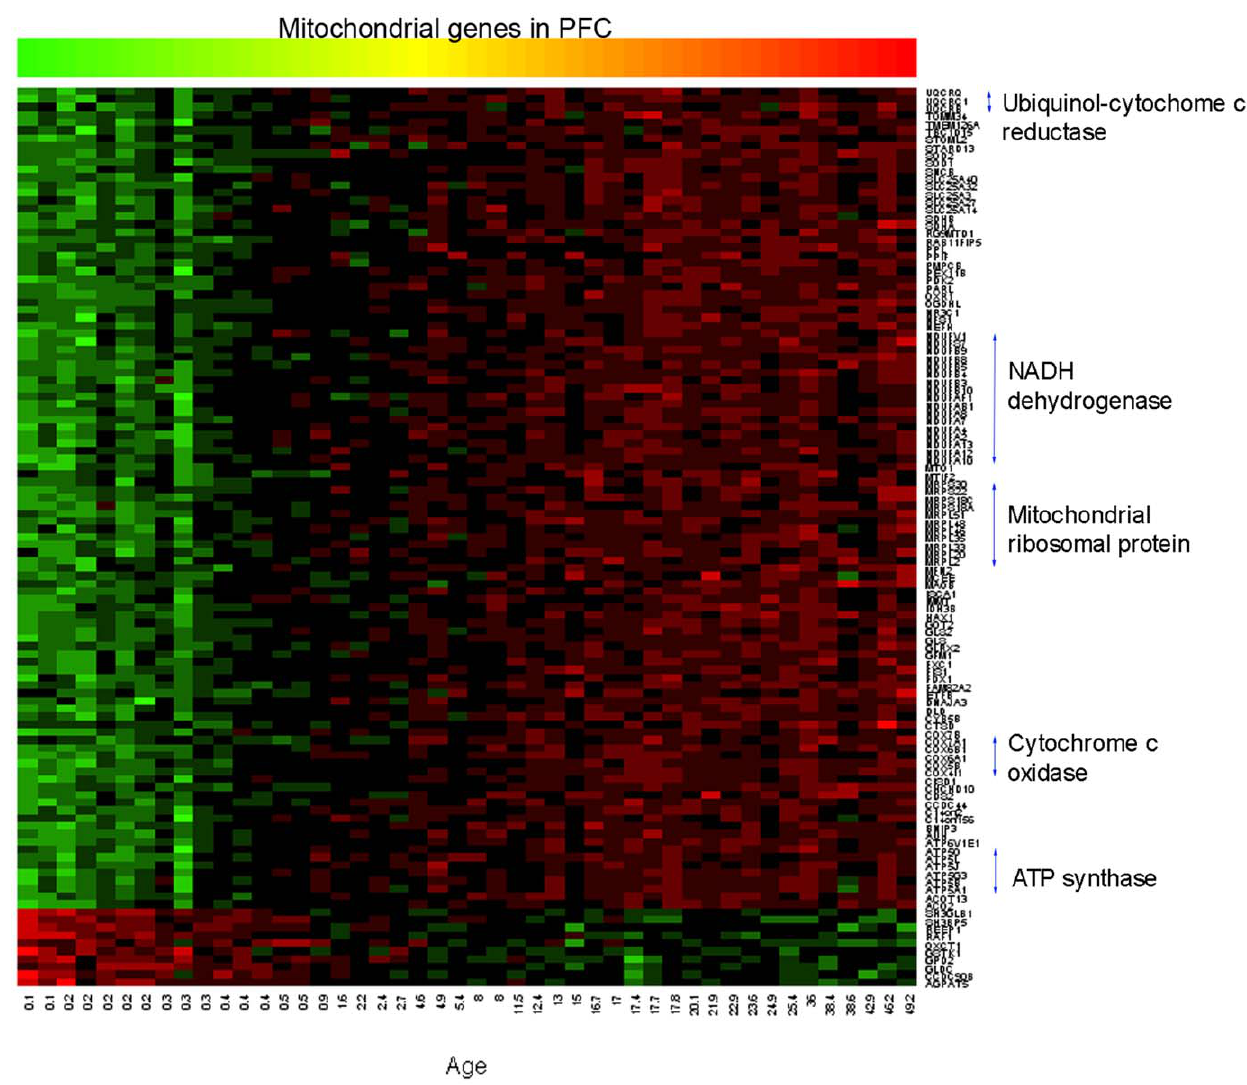
Figure 1. Developmental expression pattern of the genes associated with mitochondrial function in the PFC. A majority of the mitochondrial genes (91%) show increased expression (green to red), while only 9% of the genes show decreased expression (red to green) during postnatal development. Genes that encode different subunits of the same protein are shown on the right side. X-axis: Age (years). Y-axis: Gene symbols. In this pseudo-color heat map, increasing red intensities indicate genes with high expression levels, and increasing green intensities indicate genes with low expression levels across age. Color bar scale: hybridization intensity (log base 2) from 2.41 to 11.72.